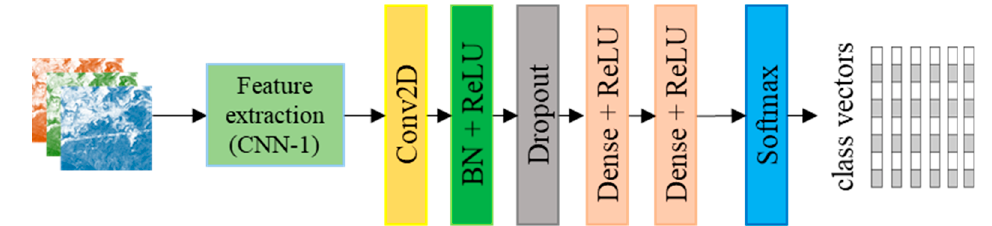
Figure 3. The architecture of CNN-2 used for class signature prediction in the proposed ZSL framework. Table 1. Details of the selected CNN-1 and CNN-2 architectures.